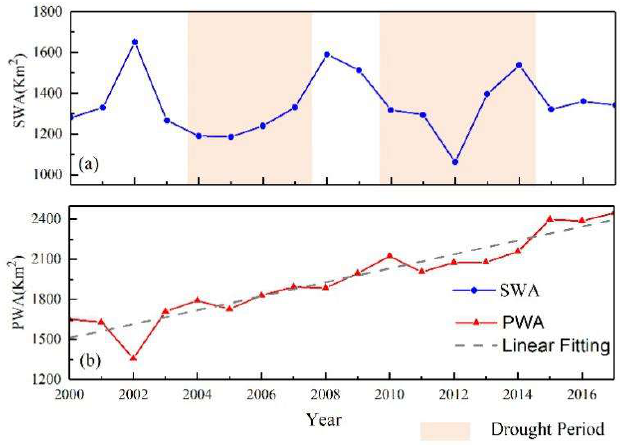
Figure 4. Variations of surface water area, ( a ) seasonal water area (SWA) and ( b ) permanent water area (PWA).